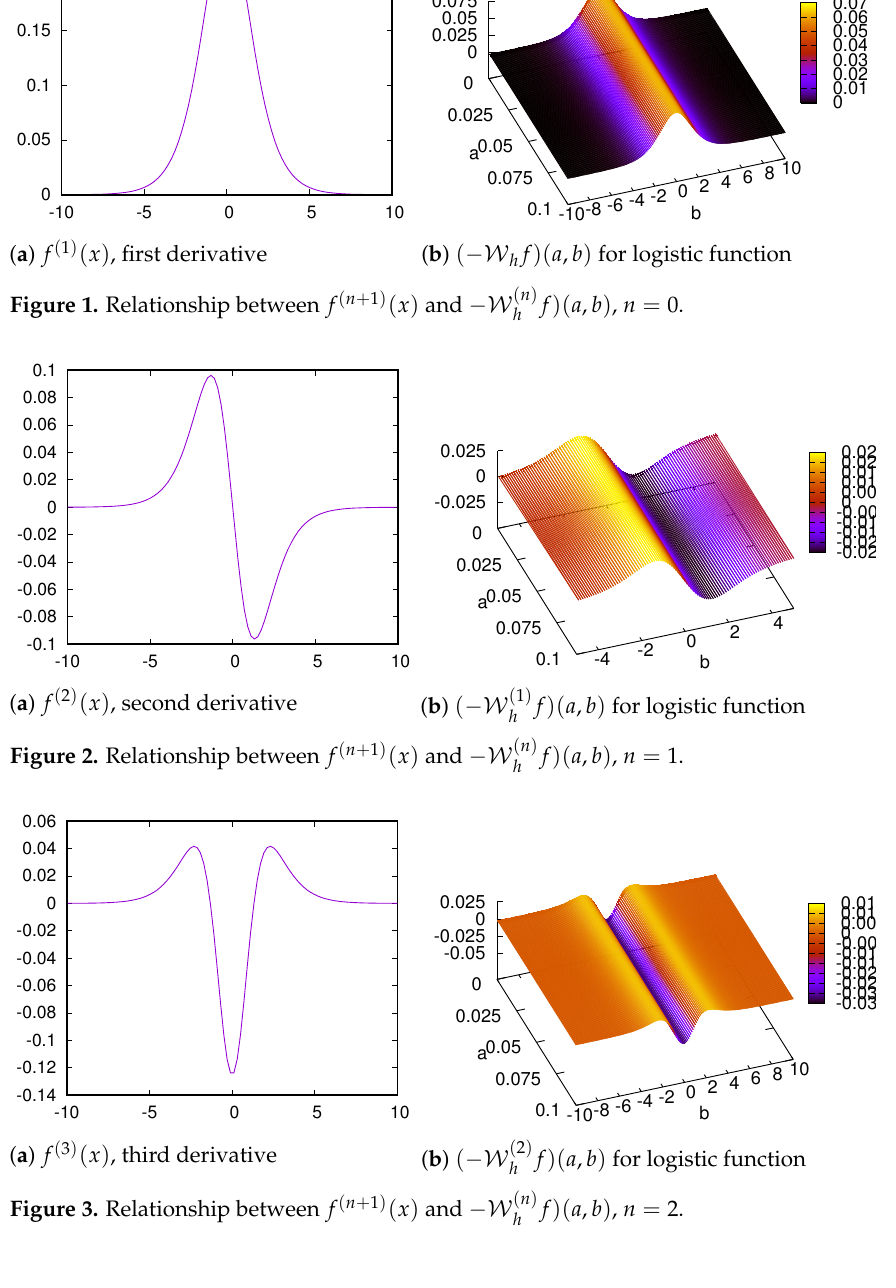
Figure 3. Relationship between f ( n + 1 ) ( x ) and −W